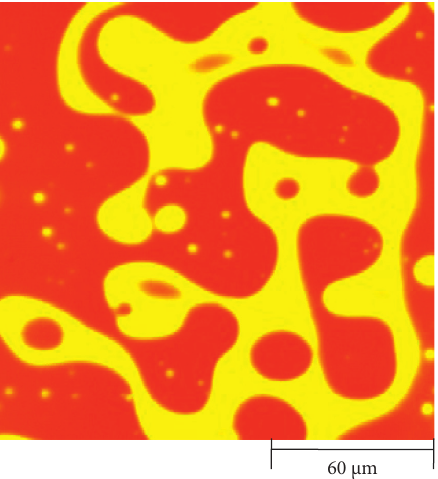
Figure 20: Fluorescence microscopic binarization image of complete development of SBS modified asphalt with 20% content of